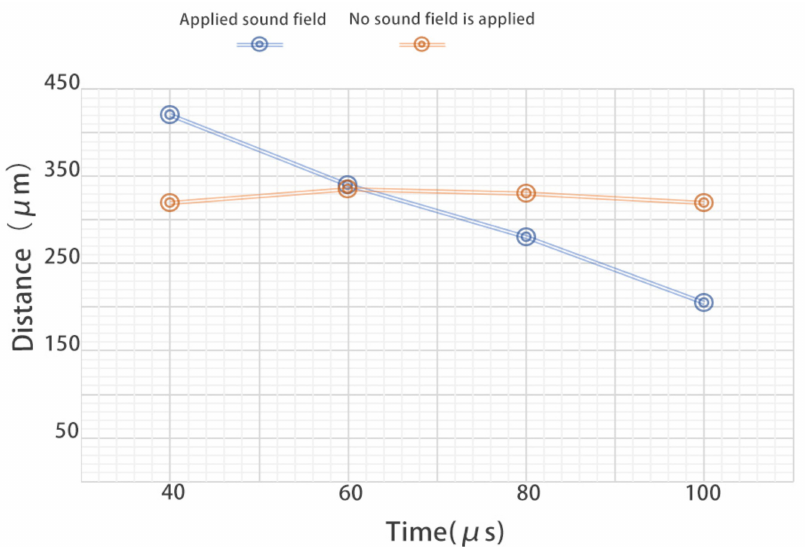
Figure 11. Comparison of the relative distance between the cavitation bubbles and the solid particles under different